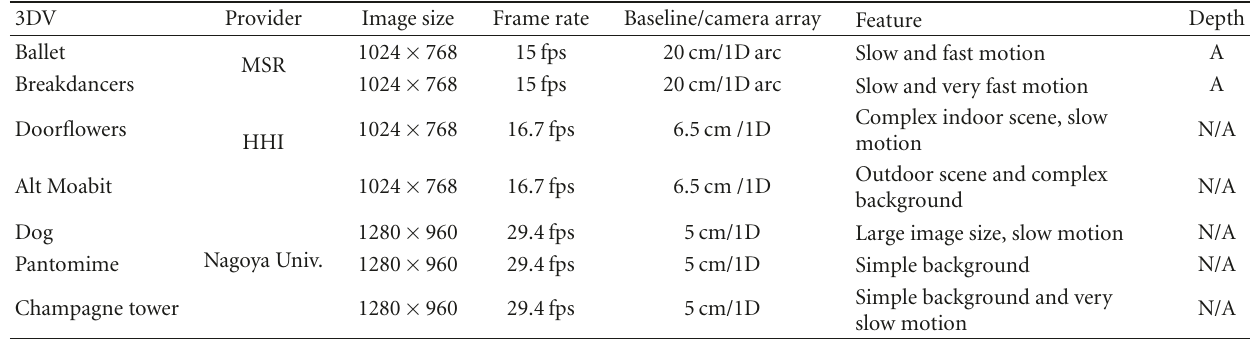
Table 1: Parameters and Features of the Test Multiview Videos.